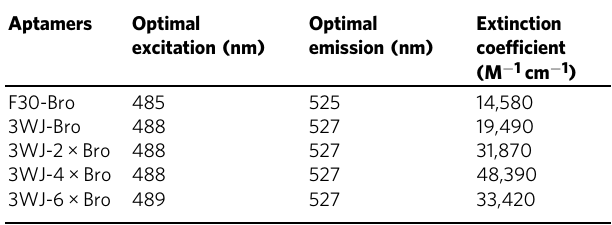
Extinction coef fi cients were all measured at pH peak at 488 nm, similar to the spectrum of the F30-Bro (Fig. 1a and Table 1). The extinction coef fi cient of all the 3WJ-nBro series was increased compared with F30-Bro, among which the extinction coef fi cient of 3WJ-4 × Bro was the highest, reaching 48390 M − 1 cm − 1 (2.32-fold higher than that of F30-Bro) (Table 1). All of the aptamer RNAs produced green fl uorescence signals after excitation with 488-nm light, and the 3WJ-nBro series exhibited higher brightness than F30-Bro (Fig. 1b). Quantitative fl uorescence data showed signi fi cantly higher